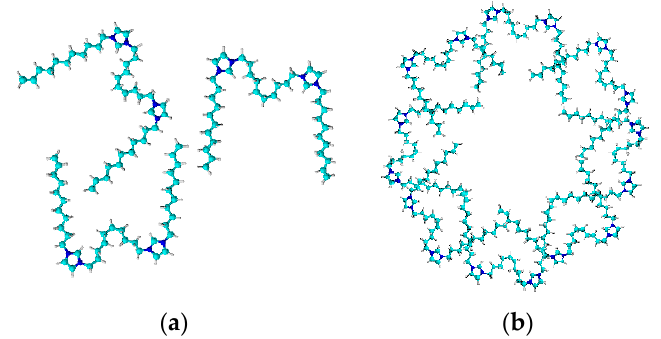
Figure 2. Schematic representation of pre-micellar ( a ) and real micellar ( b ) aggregates of BIBr.